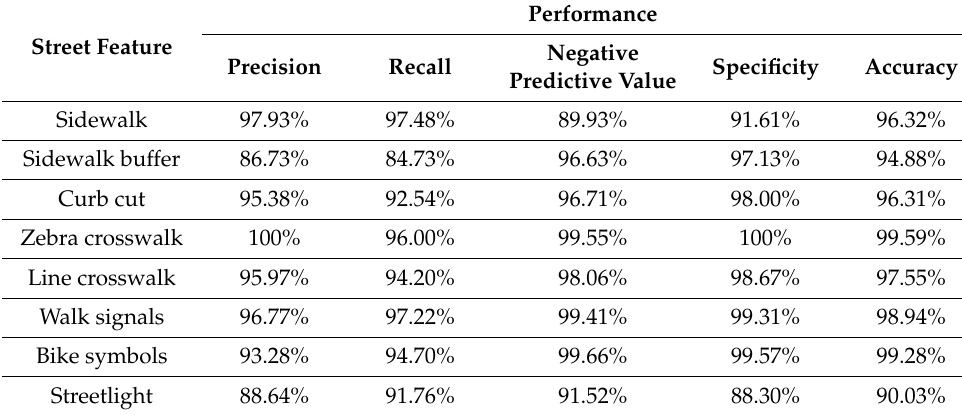
Table 2. Validation performance of image classifiers for Phoenix,